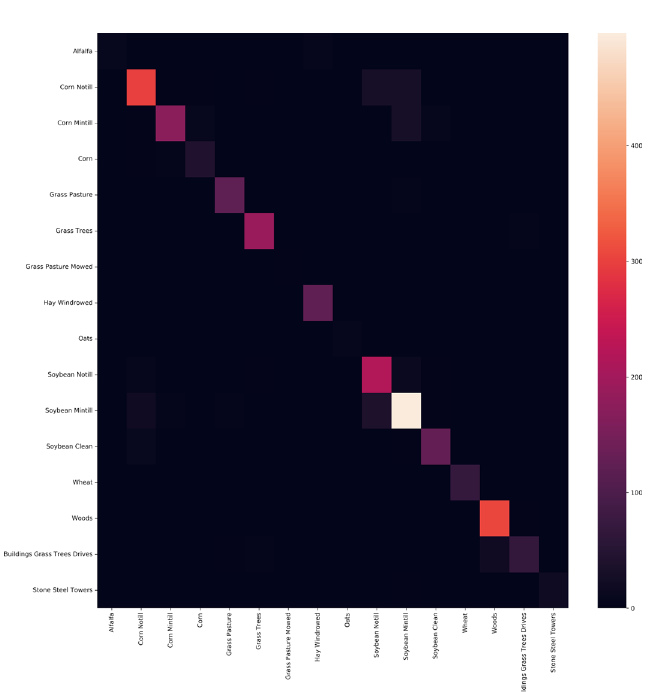
Fig. 9 Indian Pines Confusion Matrix for PCA 30 CEU-Net no patching with a 75%/25% Training/Testing